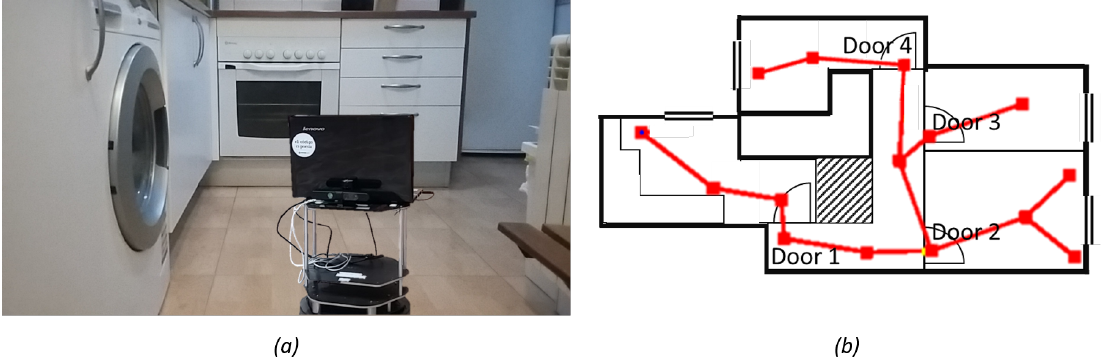
Figure 13. Real experiment in a house environment: ( a ) Turtlebot robot during the exploration process; and ( b ) the topological map of the real house-like environment generated with the exploration. The topological map consists of 15 nodes (4 of them classified as transit area and 11 classified as free area) and 14